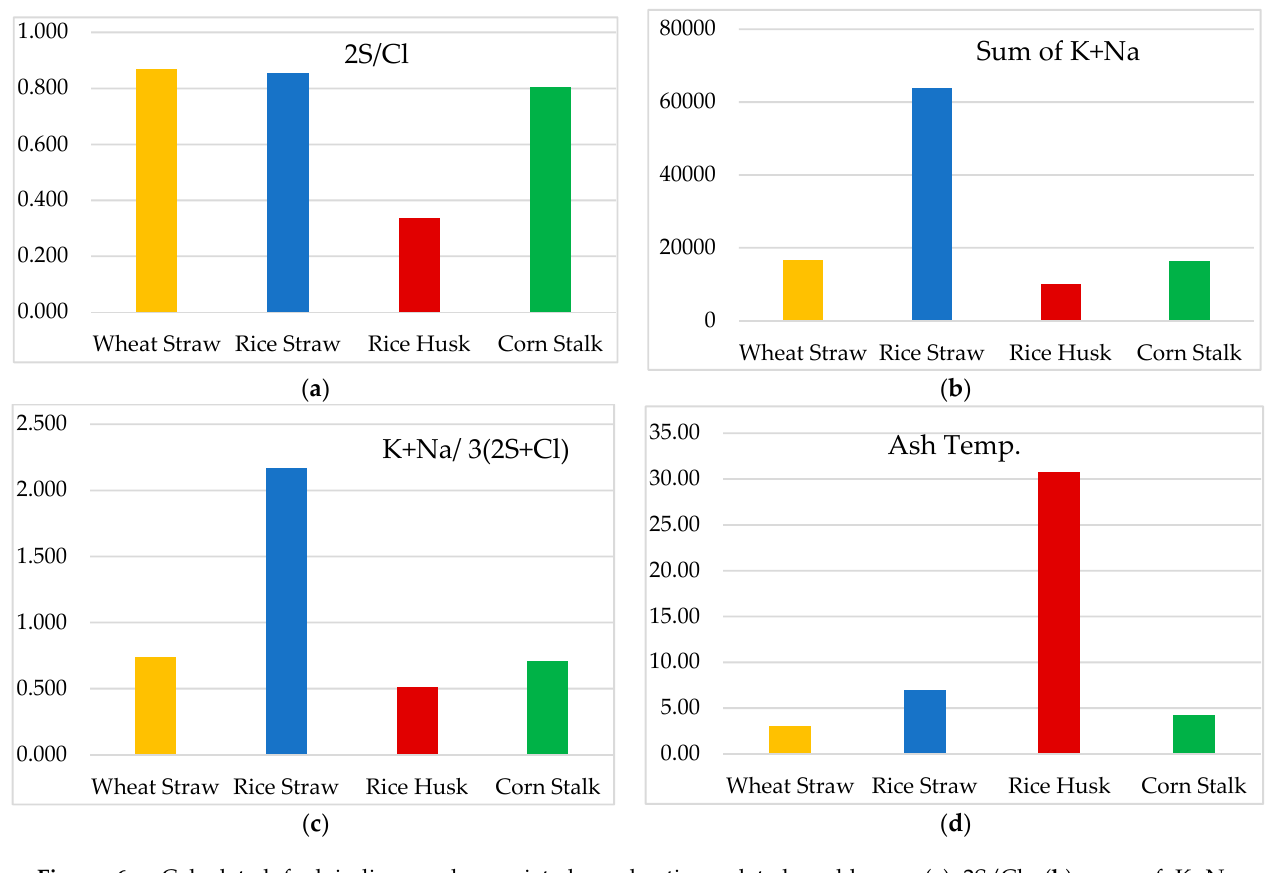
Figure 6. Calculated fuel indices and associated combustion related problems: ( a ) 2S/Cl, ( b ) sum of K+Na, ( c ) K+Na/3(2S+Cl), and ( d ) ash melting temperature.